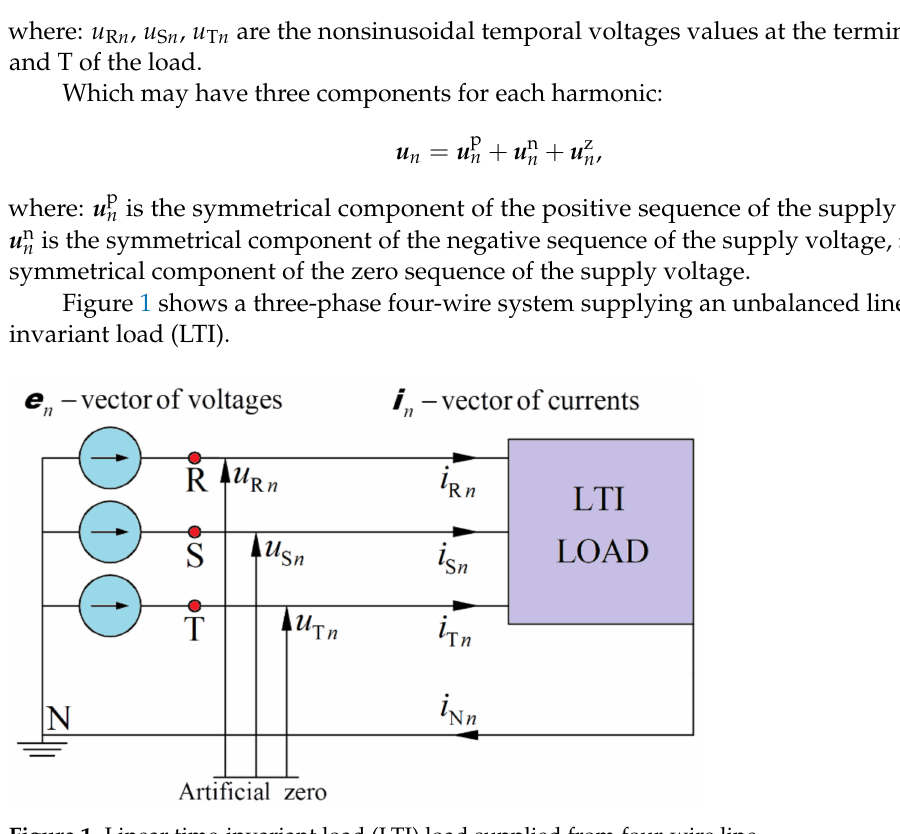
Figure 1. Linear time-invariant load (LTI) load supplied from four-wire